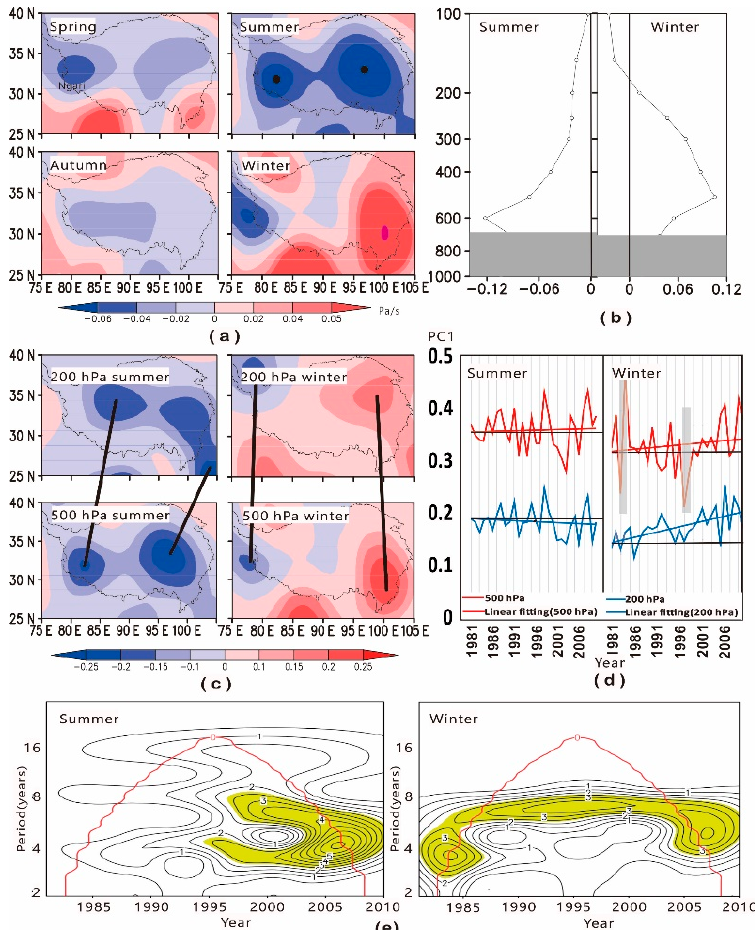
Figure 1. Distribution of the vertical velocity of air over the Tibetan Plateau. ( a ) Vertical velocity at 500 hPa in spring (March–May), summer (June–August), autumn (September–November) and winter (December–February). ( b ) Profiles of vertical velocity centers in summer (33° N, 97° E) and winter (100° E, 30° N). ( c ) Spatial distribution of the primary EOF-analyzed mode for vertical velocities at 200 and 500 hPa in summer and winter. ( d ) Temporal variation of the primary mode of the vertical velocities at 200 and 500 hPa in summer and winter. PC denotes principal component and gray areas denote large fluctuations. ( e ) Wavelet power spectrum of temporal coefficients of the primary mode of the vertical velocity at 500 hPa in both summer and winter. The red line delineates the cone of influence and the yellow areas show confidence levels >95%.